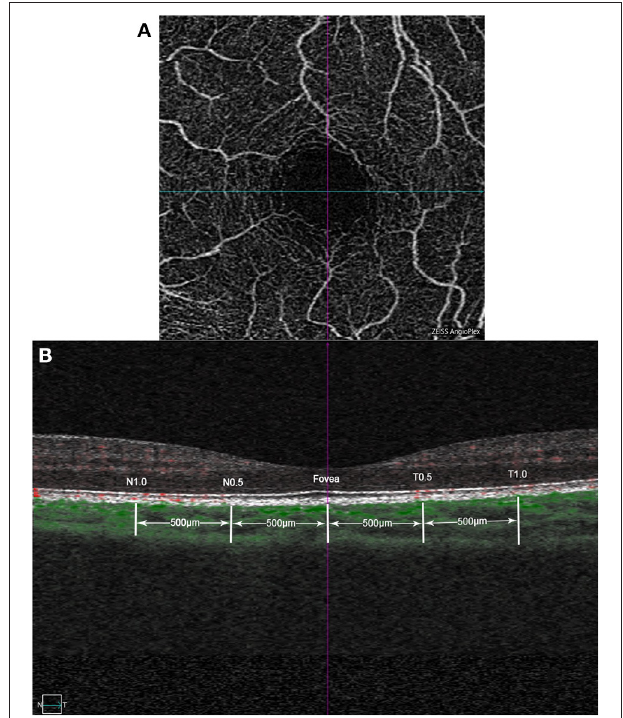
FIGURE 1 | Example images of choroidal thickness measurement based on optical coherence tomography angiography (OCTA). (A) Example of macular superficial capillary plexus scan with angiography 3 × 3mm mode. The cross center is automatic located in the fovea by the built-in software of OCTA. (B) B-scan image at the same location, with the green part identified by the OCTA algorithm as the choroidal blood flow signal. Choroidal thickness (ChT) was manually measured in the horizontal direction, including points of fovea, 0.5 and 1.0mm from the fovea in the nasal and temporal directions,